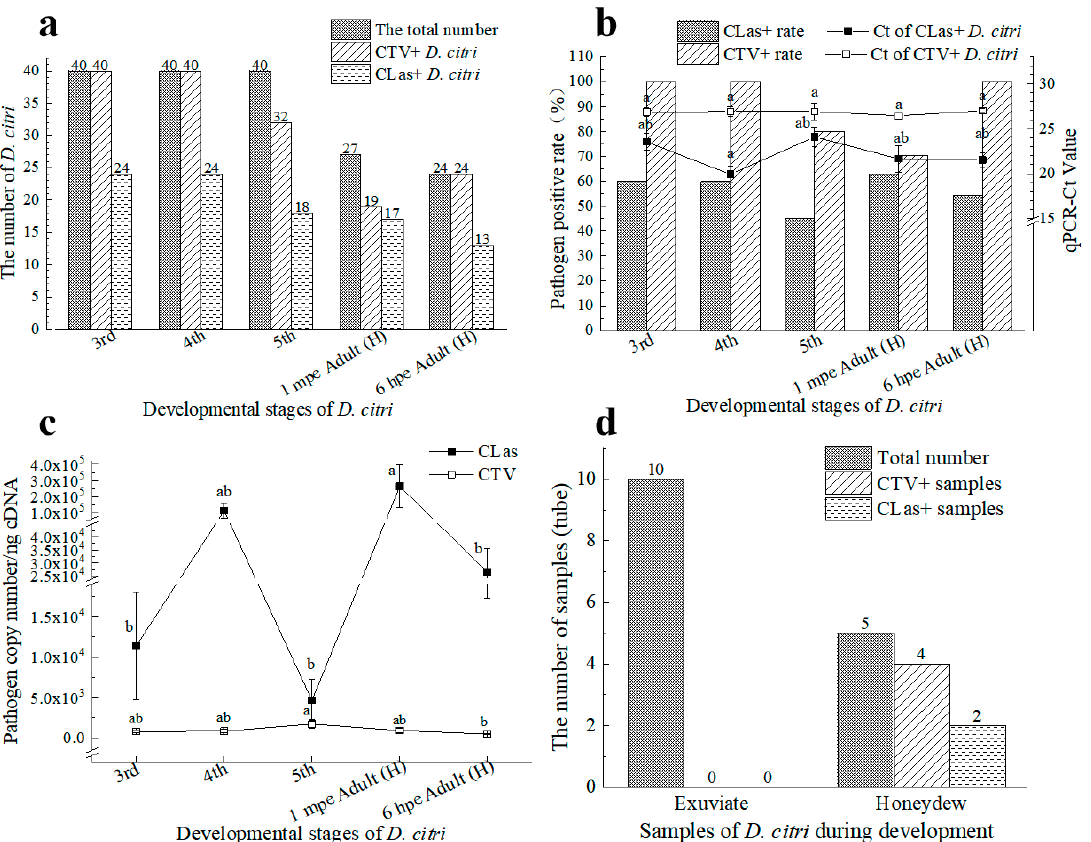
Figure 3. Acquisition of ‘ Candidatus Liberibacter asiaticus’ (CLas) and Citrus tristeza virus (CTV) by D . citri from Citrus reticulata Blanco “Shatangju” carrying both CTV and CLas (CLas+CTV+) under experimental conditions. ( a ) The number of D . citri at different developmental stages carrying CLas or CTV; ( b ) Percentage of D . citri that tested positive for CLas or CTV at different developmental stages and the average Ct values of CLas or CTV of them; ( c ) The average copy numbers of CLas or CTV carried by D . citri at different developmental stages; ( d ) CLas and CTV-carrying status of exuviate and honeydew of D . citri . CLas+: CLas positive; CLas − : CLas negative; CTV+: CTV positive; 1 mpe Adult (H): D . citri adults that were 1 min after emergence on healthy Citrus reticulata Blanco “Shatangju”; 6 hpe Adult (H): D . citri adults that were 6 h after emergence on healthy Citrus reticulata Blanco ‘Shatangju’. Different letters in the figure indicate significant differences at p < 0.05